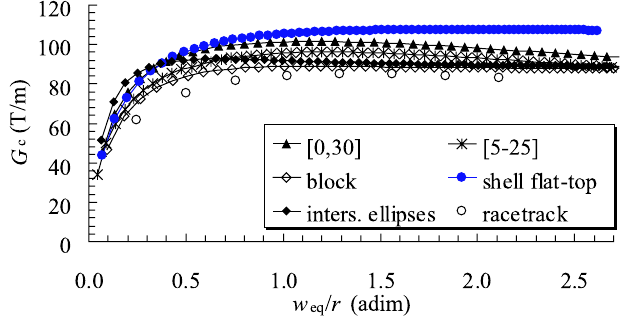
FIG. 23. (Color) Numerical evaluation of the critical gradient versus equivalent sector width (41) in six coil layouts with an aperture radius of 100 mm ( (cid:3) (cid:2) 0 : 28